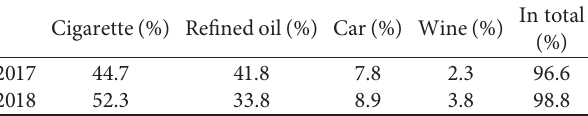
Table 7: Proportion of the tax revenue of the four tax items in domestic consumption tax